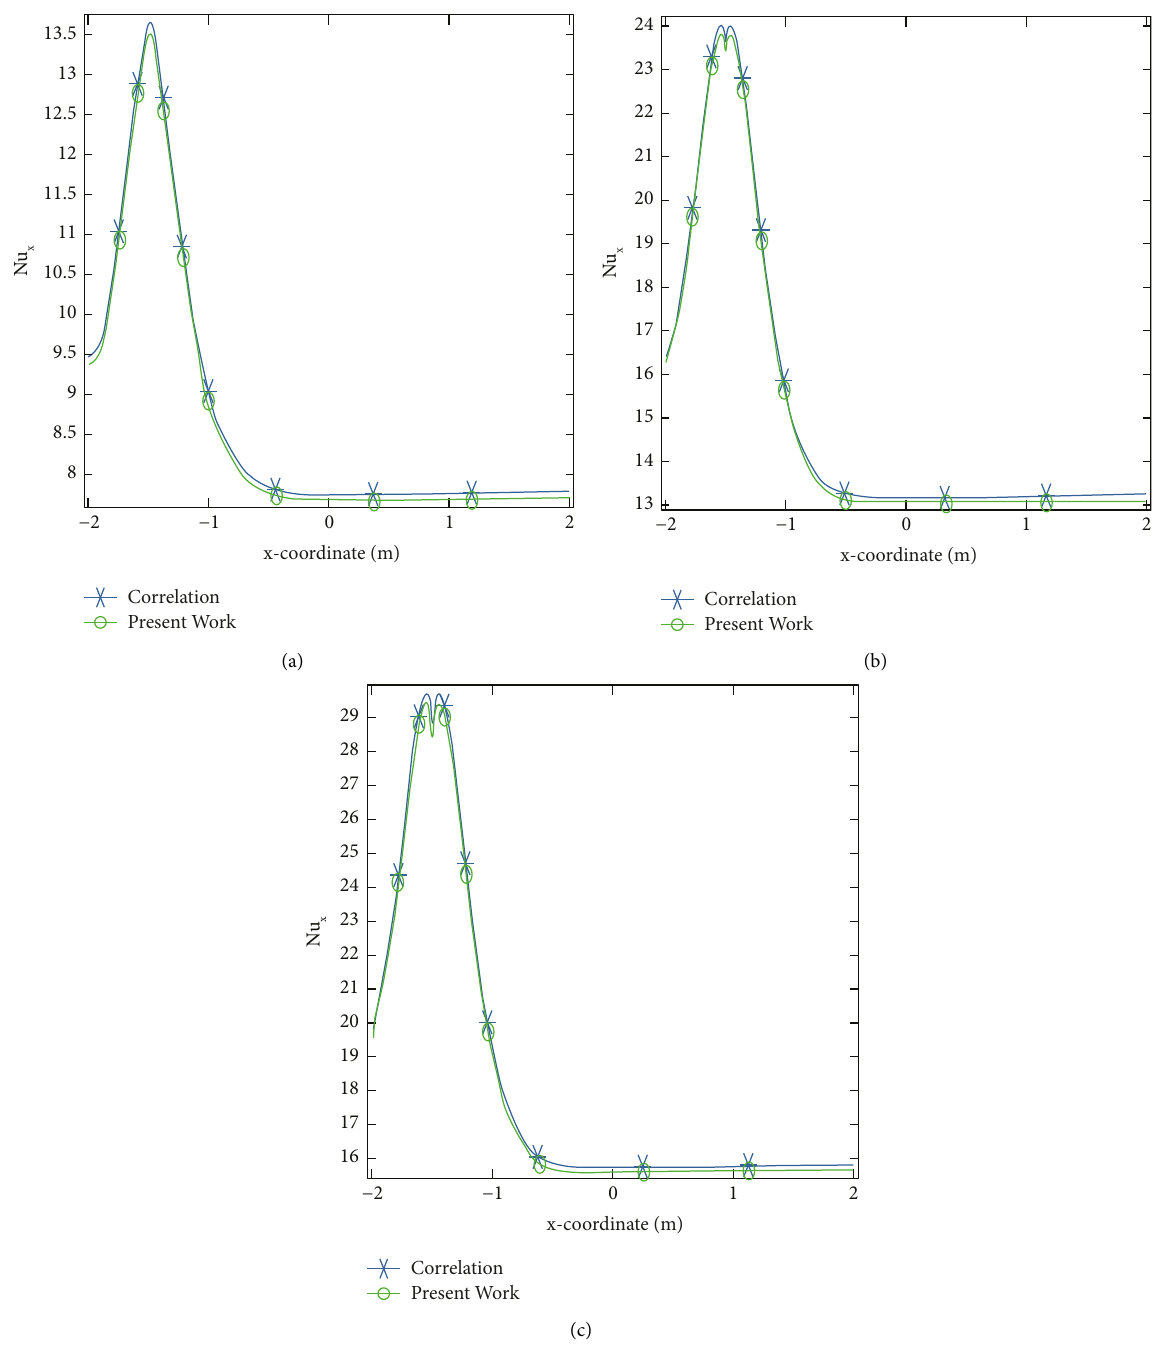
Figure 6: The comparison of local Nusselt number’s correlation with the present work: (a) Re � 2000, r � 0.3, and n � 0.9; (b) Re � 2000, r � 0.3, and n � 0.9; (c) Re � 2000, r � 0.3, and n �